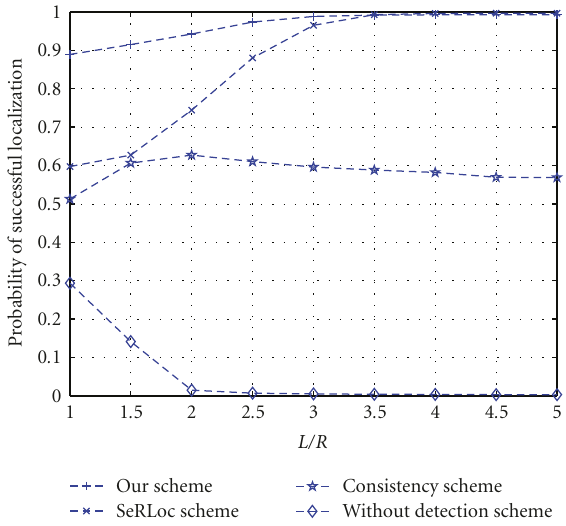
Figure 6: Probability of successful